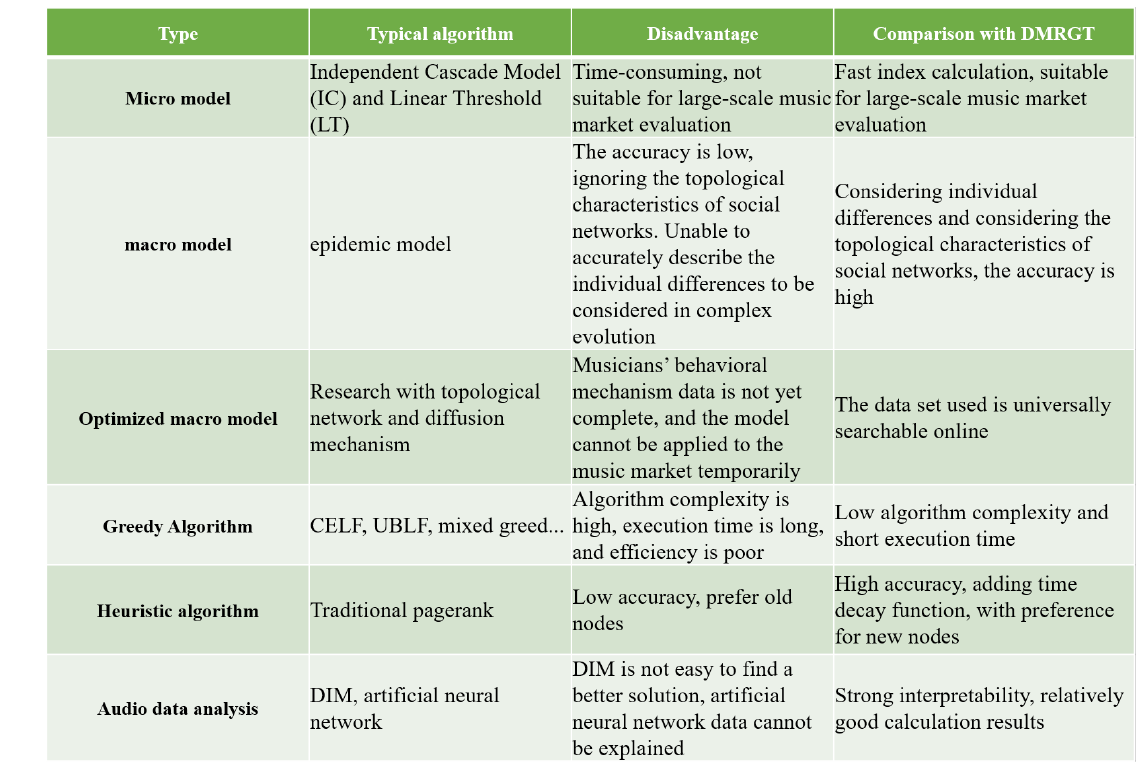
Figure 2. Algorithm comparison table.